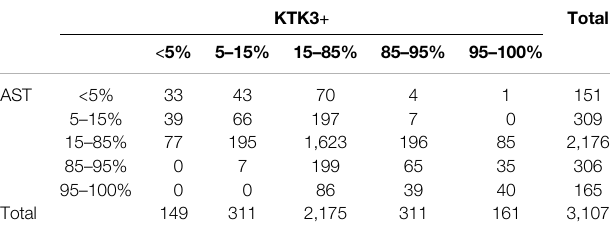
TABLE 3 | Number of children in each motor skills pro fi ciency level per test Chi 2 (25) (cid:1) 897.5, p < 0 .001. KTK3 + Total